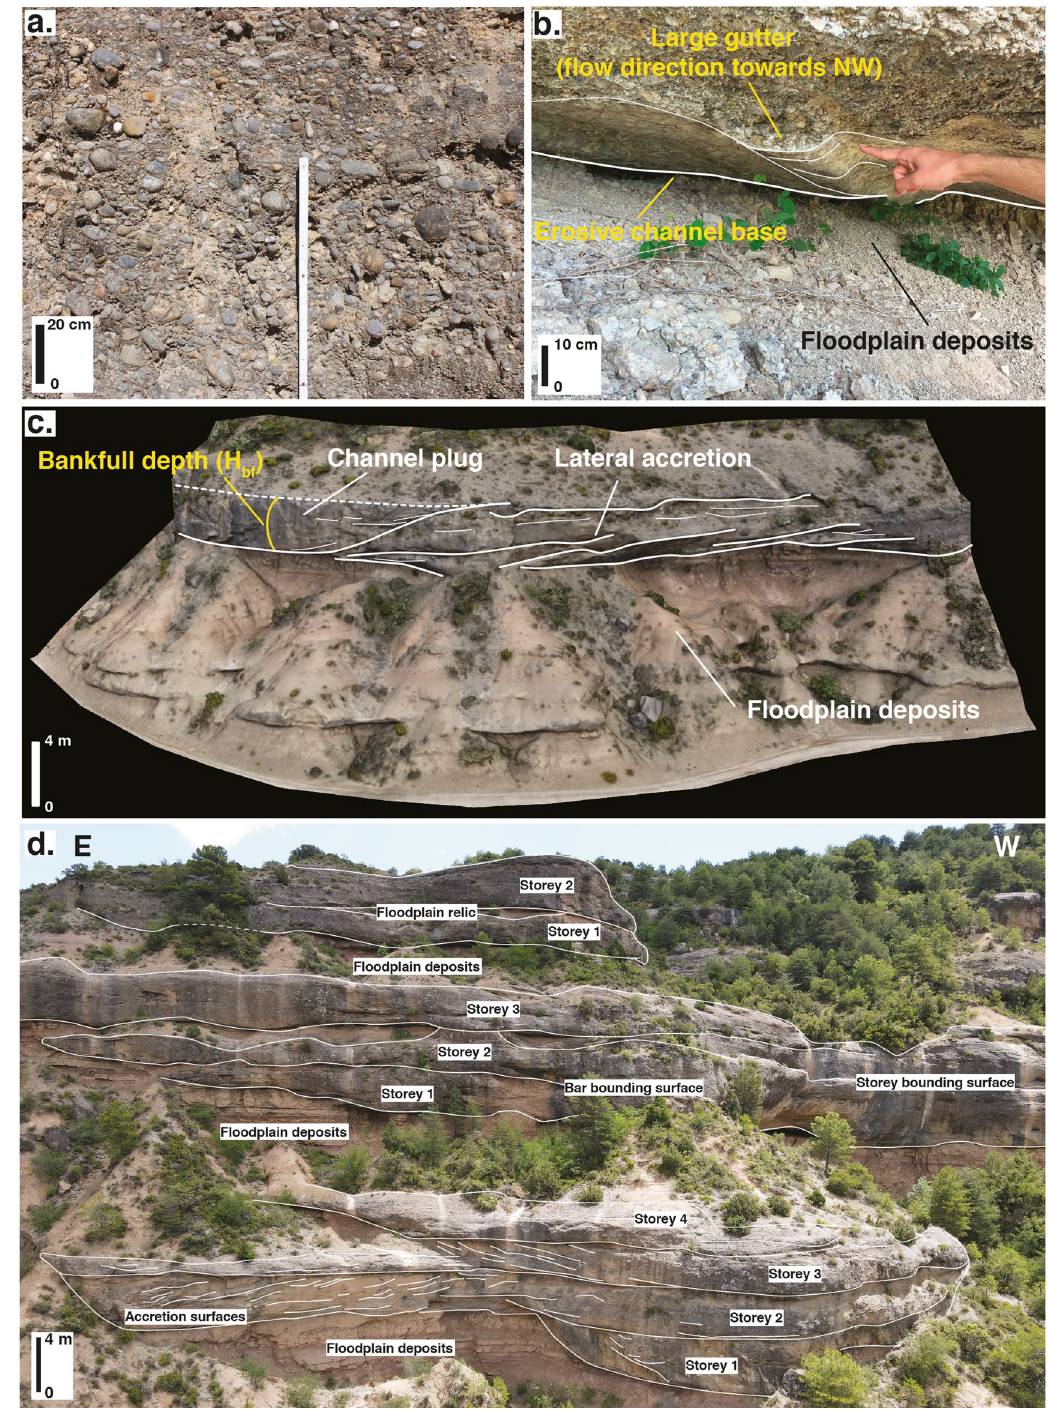
Figure 4. Outcrop photographs. ( a ) Channel basal gravel from which grain size estimates are obtained. ( b ) Example of a large gutter cast used to reconstruct flow direction in combination with pebble imbrications, base of a channel in the Olson Sheet (HA sequence 2) ( c ) 3D outcrop model showing a channel plug and lateral accretion deposits, which allow measuring bankfull height (H bf ) ( d ) Multi-storey stacking pattern observed in the LA interval of sequence 4. An unannotated version of this photographic panel is provided as supplementary Figure